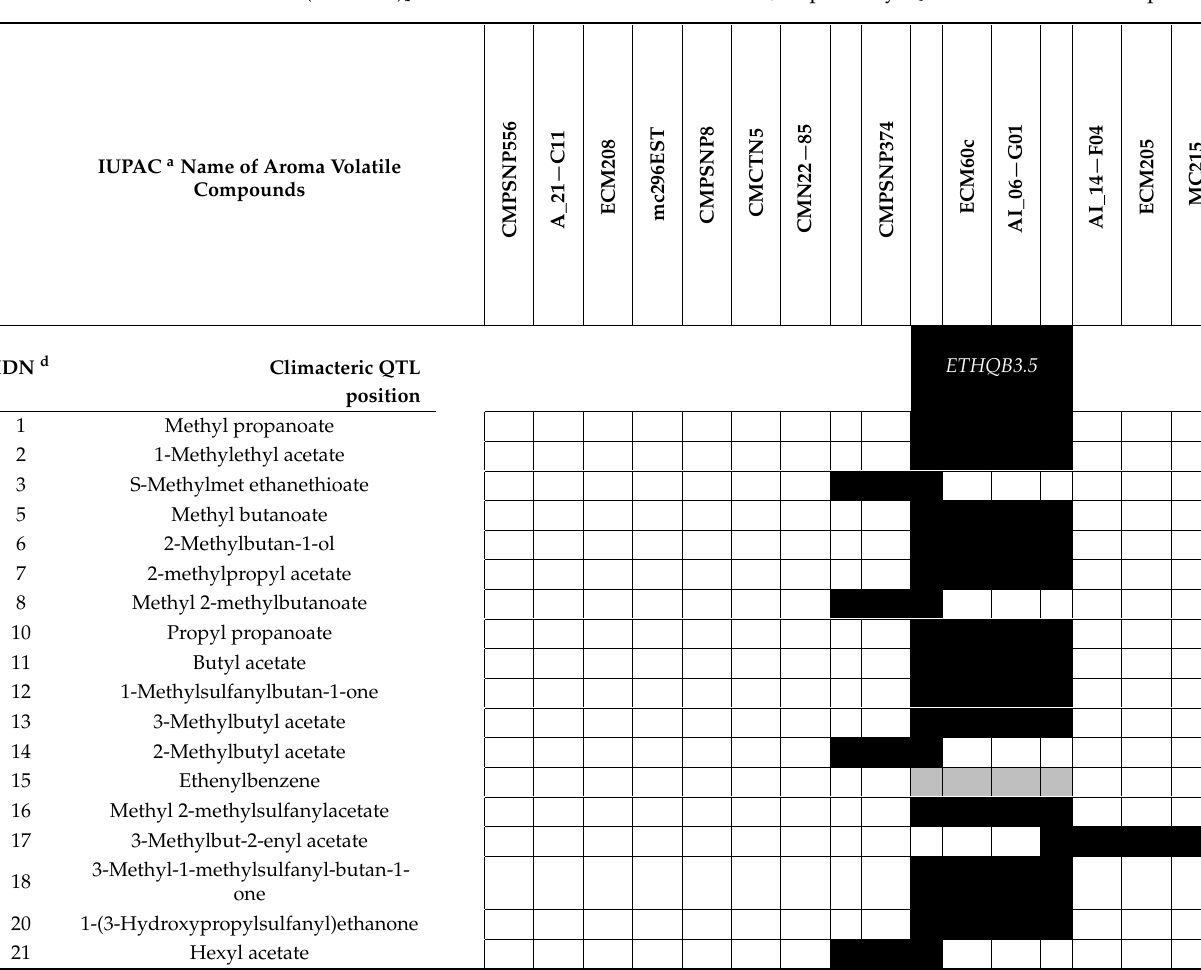
Table 4. QTL mapping of individual aroma volatile compounds in melon chromosome 3 is depicted at the top according to [49] using the conventional nomenclature [61] for the chromosomes. For each aroma volatile, the estimated position of the QTL is indicated by a shadowed area (grey or black) when the SC [‘Shongwan Charmi’ (PI161375)] allele increased or decreased the trait, respectively. Question mark indicates position of mapping in